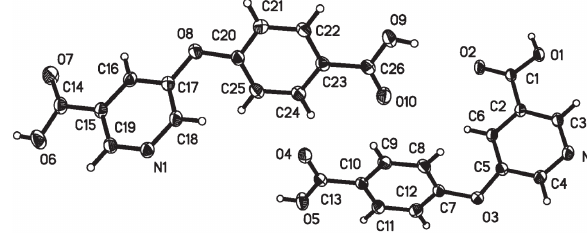
Table 1: Data collection and handling.